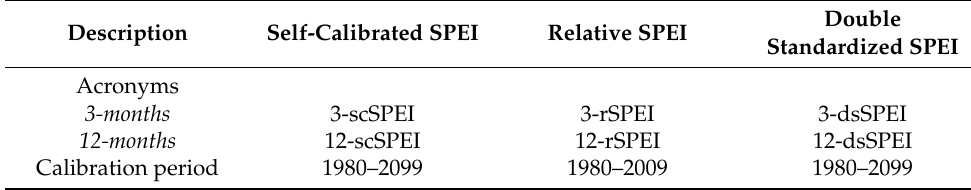
Table 3. Definition of the methods to estimate the drought conditions.